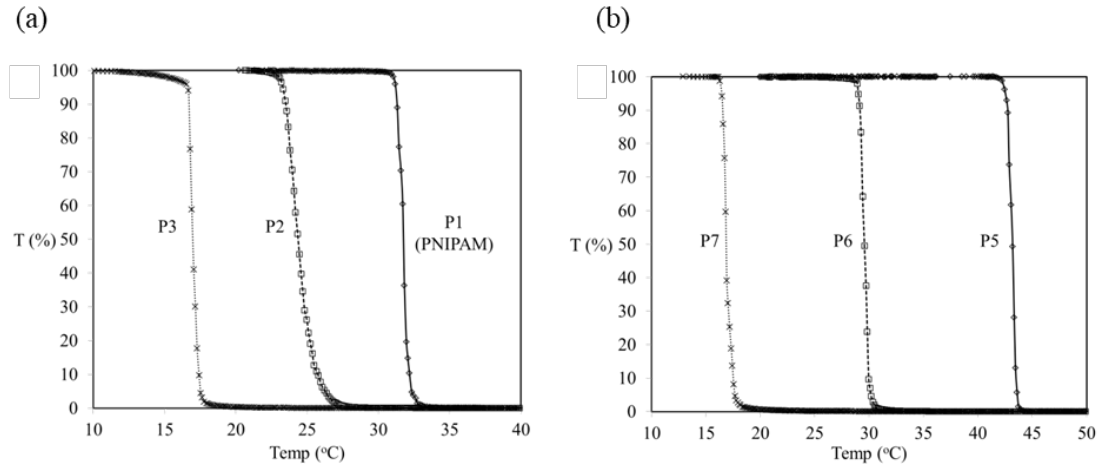
Figure 1. Transmittance of copolymers (0.5 wt %) in water.